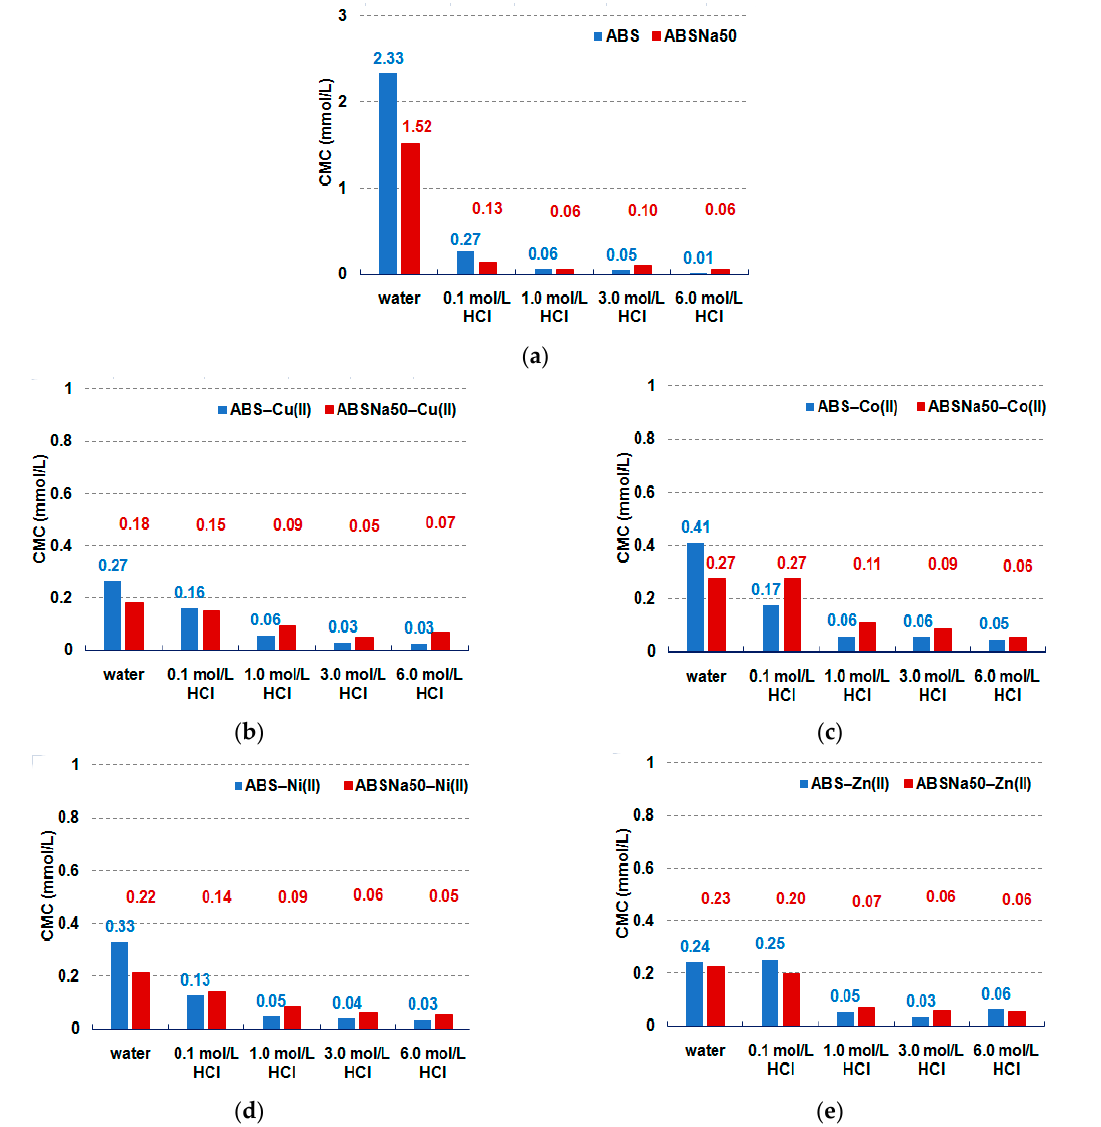
Figure 2. The CMC values comparison obtained for ABS (this paper) and ABSNa50 surfactants for systems without ( a ) and with ( b – e ) heavy metals such as Cu(II) ( b ), Co(II) ( c ), Ni(II) ( d ) and Zn(II) ( e ) [19].